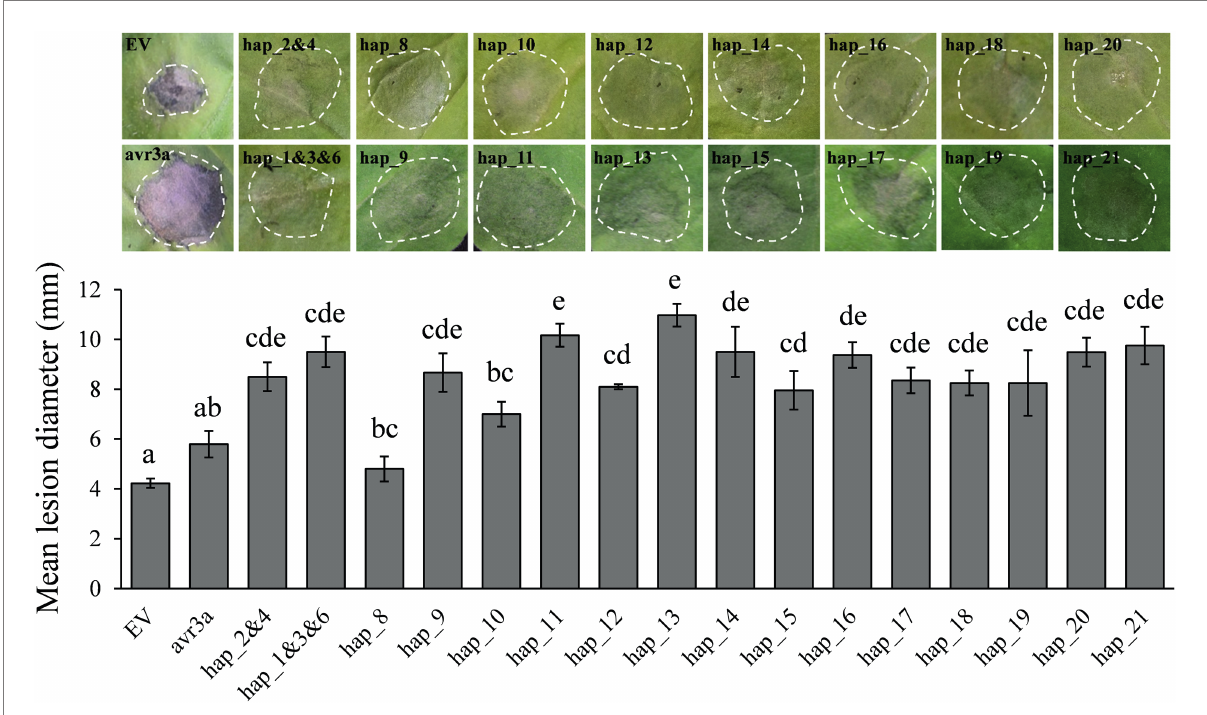
FIGURE 5 Transient overexpression of Pi02860 haplotypes in N. benthamiana increases P. infestans lesion diameter to various degrees compared with free GFP. Bottom: statistical test; Top: representative images of pathogen expression. EV and avr3a are negative and positive controls, respectively. Hap_1 to Hap_21 are the codes of 21 haplotypes detected. Hap_2 and 4 are deduced into the same isoform and Hap_1, 3 and 6 are deduced into another the same isoform, thus only one vector was constructed for each of the two haplotype groups. Results shown are derived from the mean of at least three independent biological replicates.